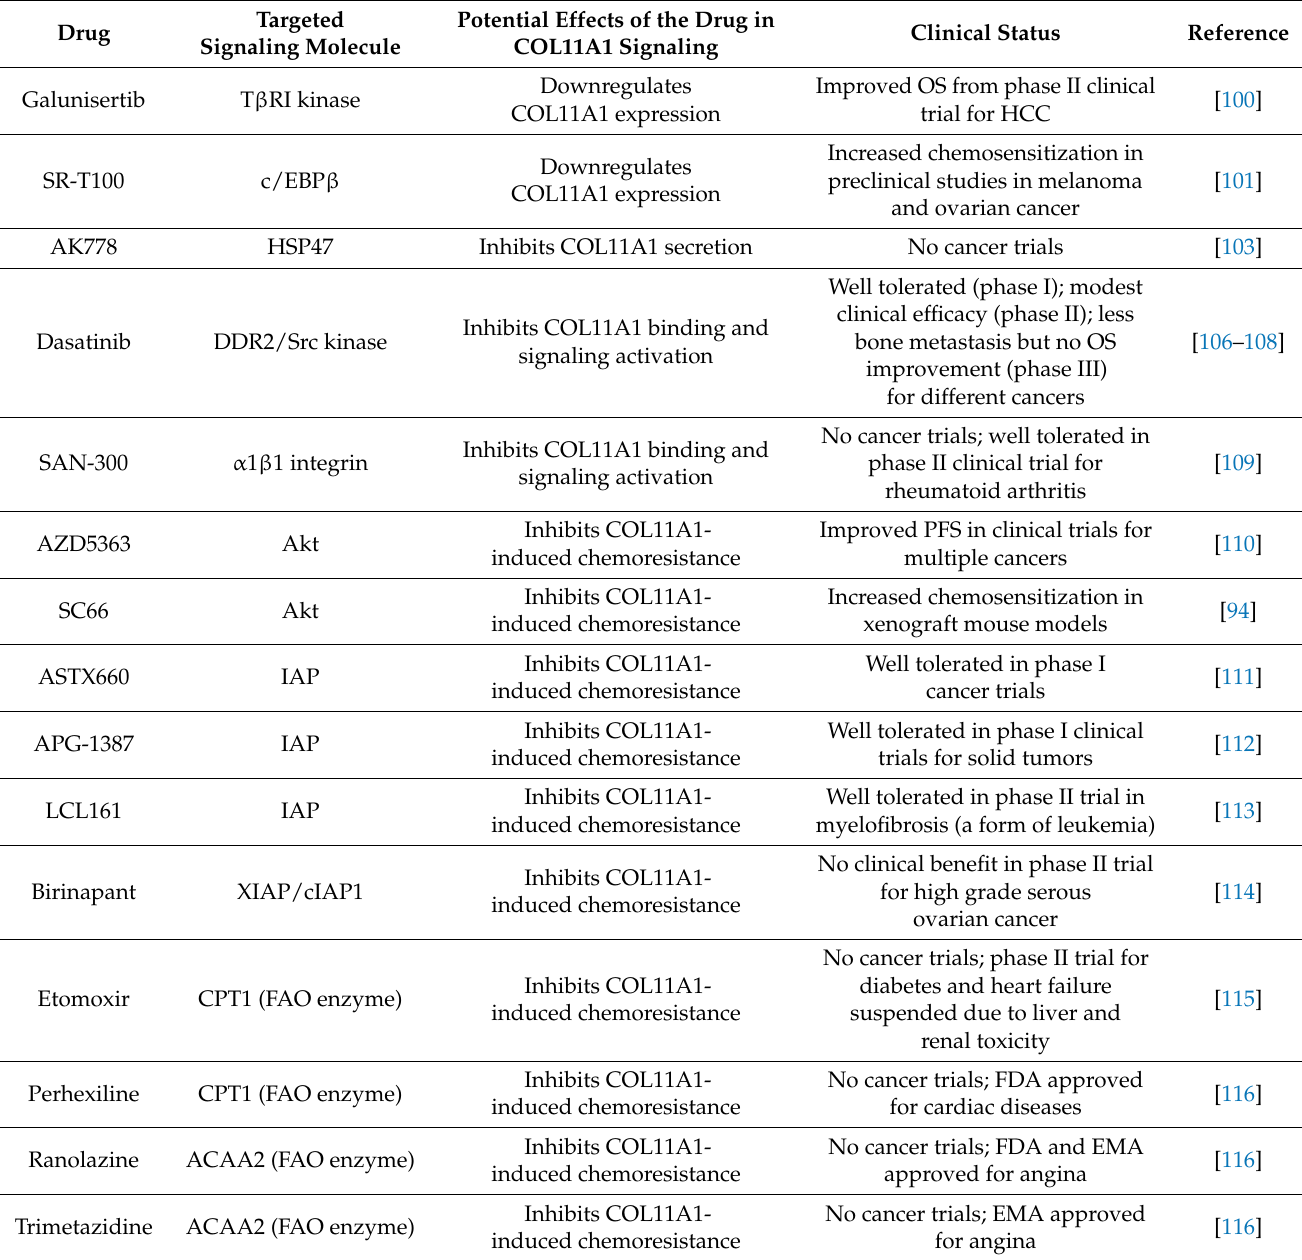
Table 2. Potential inhibitors of COL11A1